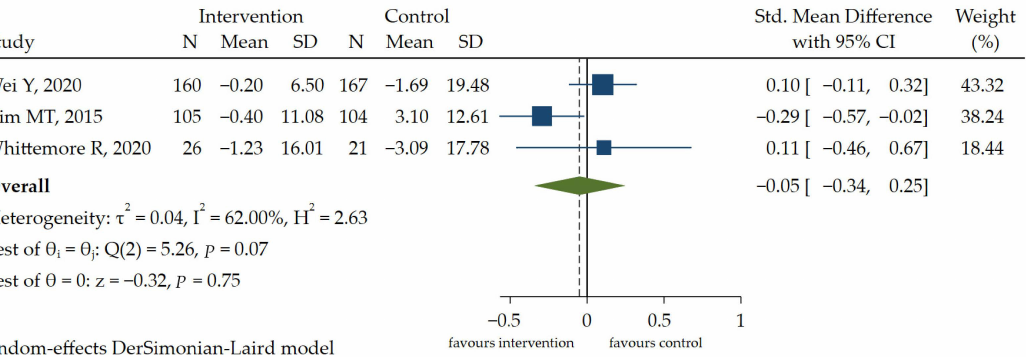
Figure 3. The forest plot of the effect of HL intervention on SBP